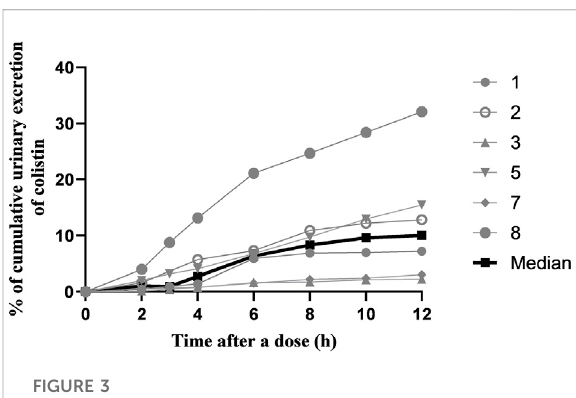
FIGURE 3 The cumulative urinary excretion percentage of colistin during a dose interval after 72 h of multiple-dose